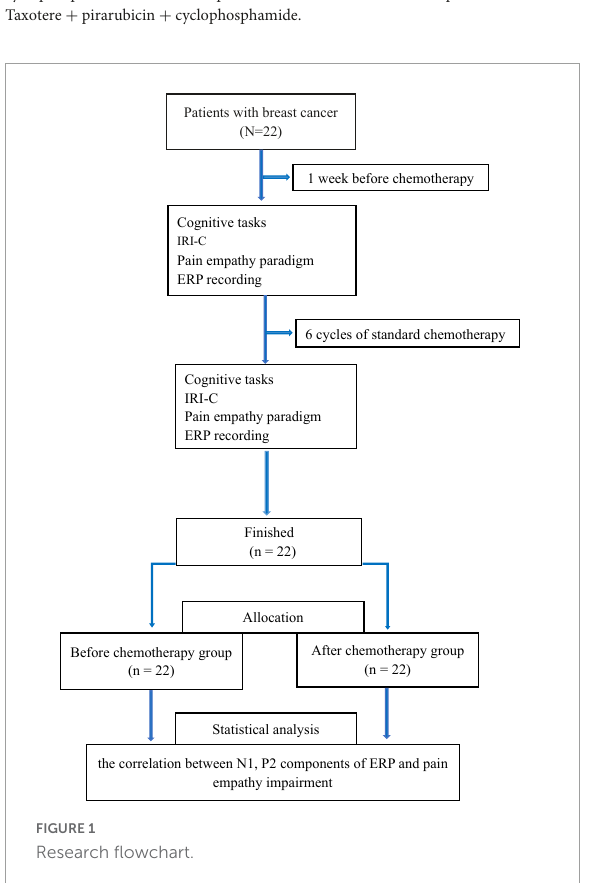
FIGURE1 Research